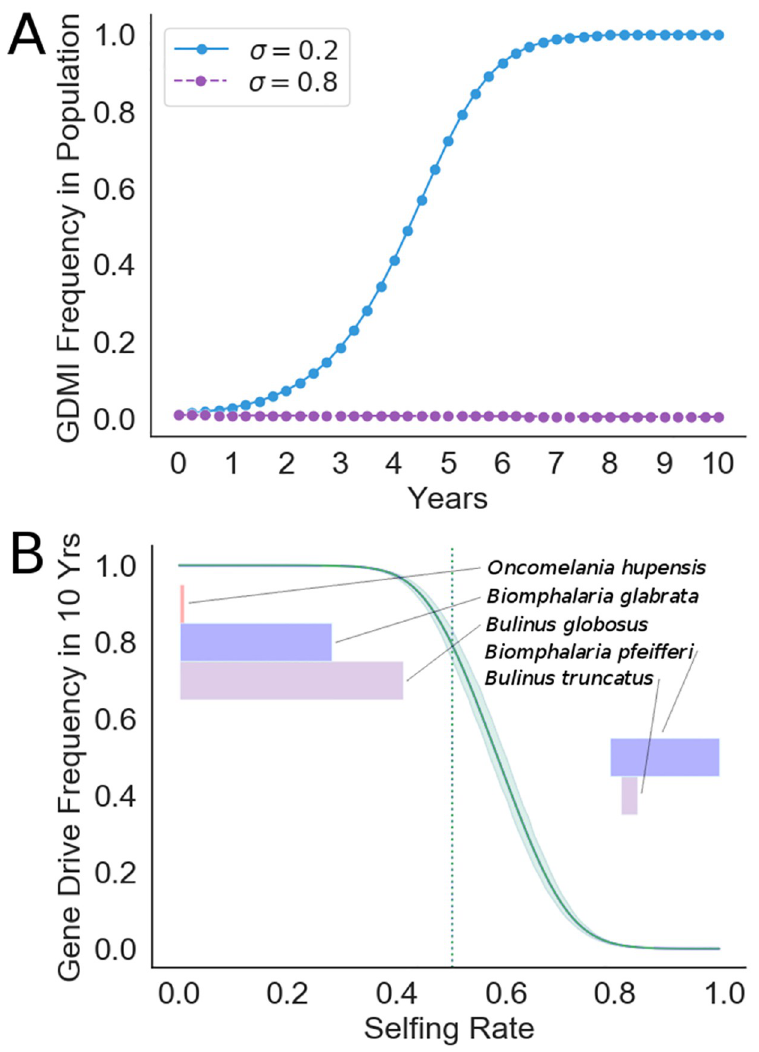
Fig 3. Self-fertilization rate strongly affects establishment of gene drive in a 10 year window. (A) Simulation of gene drive invasion under default conditions when self-fertilization rate is low at 0.2 and high at 0.8. (B) Endpoint sensitivity analysis depicting the gene drive frequency in the population after 10 years under variable self-fertilization rates ( σ ) from 0 to 1. Bootstrapped 95% confidence intervals are reported on the range of results when the fecundity cost of inbreeding varies on the uniform distribution [0,0.6]. The vertical dotted line designates σ = 0.5, which is the value used in future simulations to represent an intermediate selfing rate from those observed. Shaded bars colored by genus display ranges (mean ± 1 s.d.) of observed selfing rates for each host snail species for which empirical measures exist [41]. Vertical positioning of the bars is ordered by minimum selfing rate according to the displayed